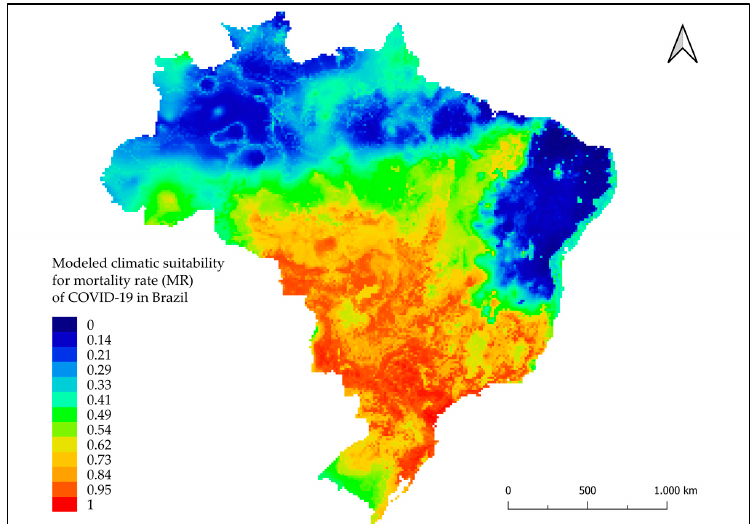
Figure 4. Modeled climatic suitability for mortality rate (MR) of COVID-19 in Brazil. Modeled climatic suitability (consensus model) for all seven algorithms under current climate conditions. Data used for modeling was provided by WorldClim [17]. For visualization, maps were built using QGIS version 3.16 (h tt ps://qgis.org/pt_BR/site/, accessed on January 10 2022).